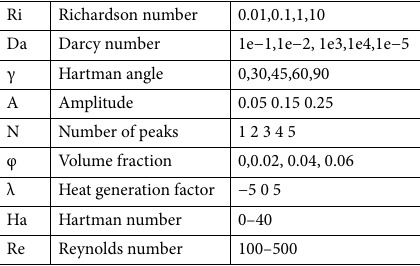
Table 3. Parameters under